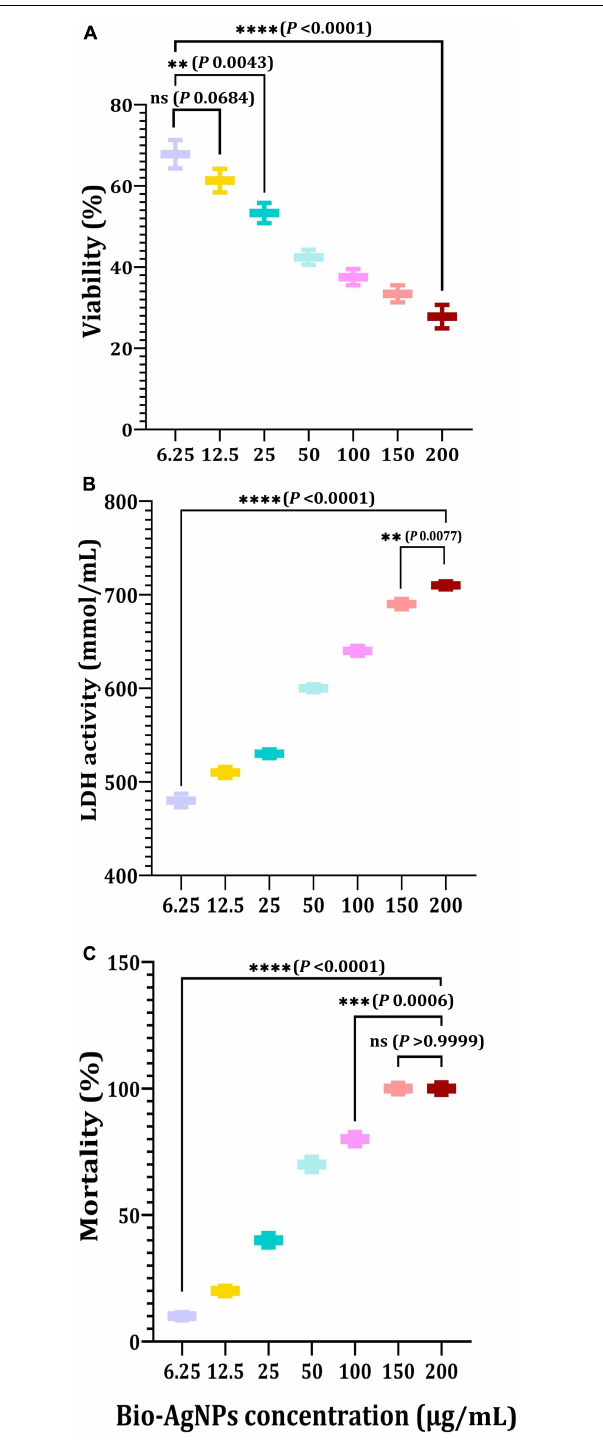
FIGURE 11 | In vitro cytotoxicity of the Nocardiopsis dassonvillei M1-derived Bio-AgNPs against CaCo2 cell lines. (A) MTT assay. (B) LDH leakage assay. (C) Mortality of brine shrimp. The data are represented in the form of a bar graph and plotted using mean ± SE of three replicates. P -values for significantly different mean values, ns , non-significant , P < 0.01 ( ∗∗ ), P < 0.001 ( ∗∗∗ ), P < 0.0001 ( ∗∗∗∗ ).